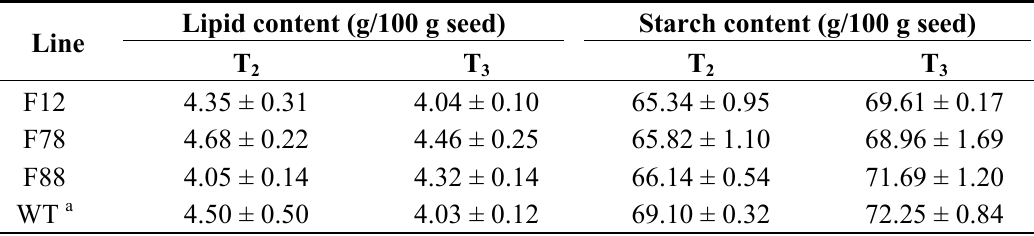
and T kernels in three transgenic 2 3